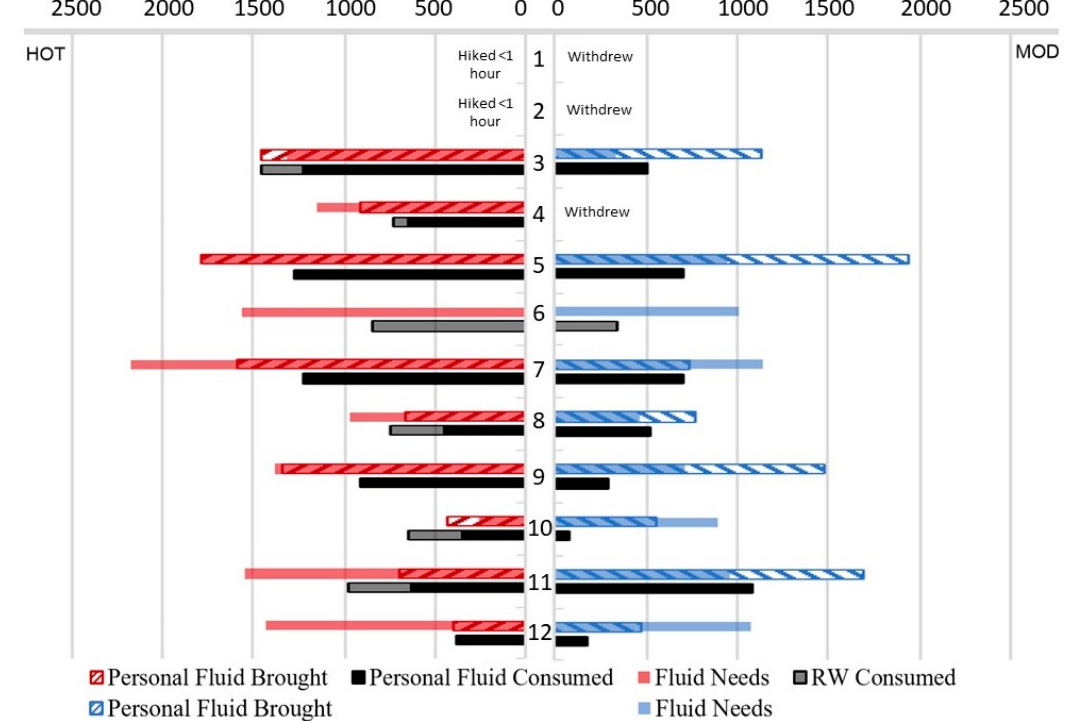
Figure 4. Fluid needs (sweat loss) in mL versus fluid brought and consumed in HOT and MOD. Note: Data of participants 1 and 2 is not included as they completed only one of four climbs. of participants 1 and 2 is not included as they completed only one of four